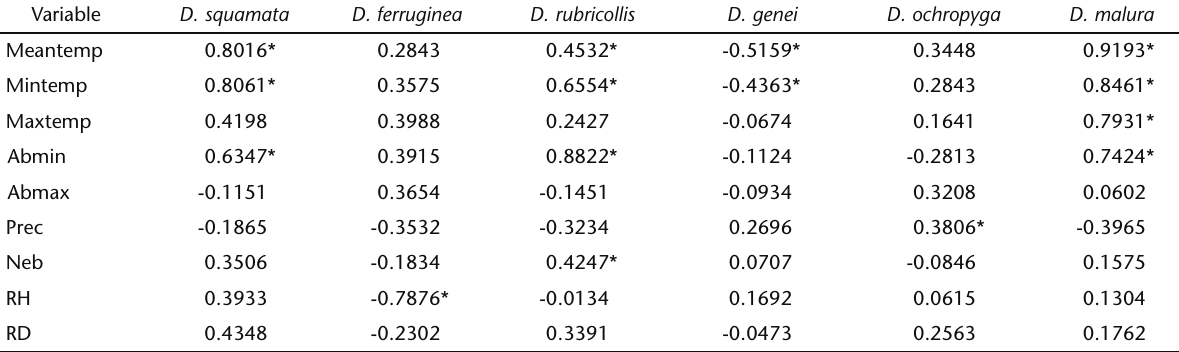
Table IV. Results of the correlation between discriminant variables and the first canonical function comparing each one species with the remaining five species The variables most correlated with the function are indicated by the asterisk. (Meantemp) mean annual temperature, (Mintemp) mean annual minimum temperature, (Maxtemp) mean annual maximum temperature; (Abmin) absolute minimum temperature, (Abmax) absolute maximum temperature, (Prec) annual total precipitation, (Neb) mean annual nebulosity, (RH) mean annual relative humidity, (RD) mean annual rainy